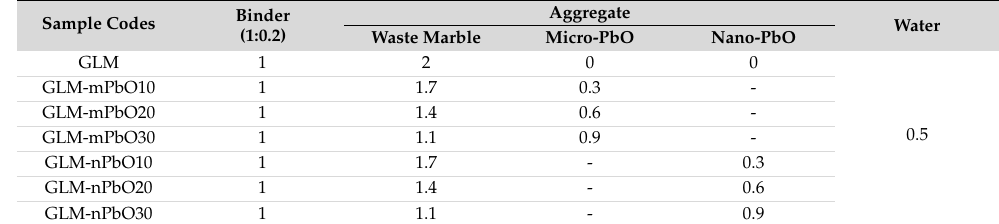
Table 2. Mixing ratios of the mortar samples.